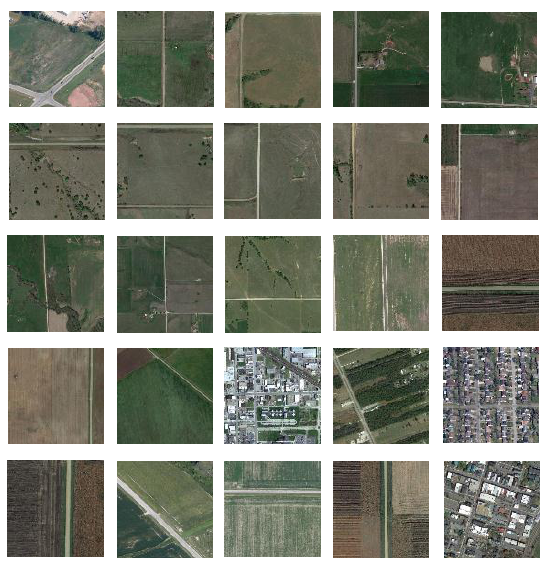
Figure 3. Some remote sensing images with straight road examples from the RSSCN7 dataset.